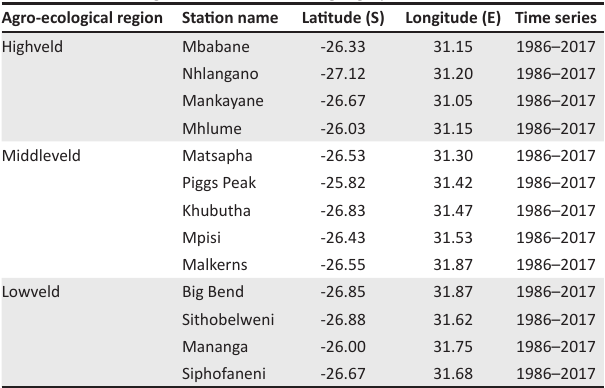
FIGURE 1: Map of Eswatini with agro-ecological zonation and the rainfall stations. TABLE 3: Meteorological stations and their geographic coordinates.